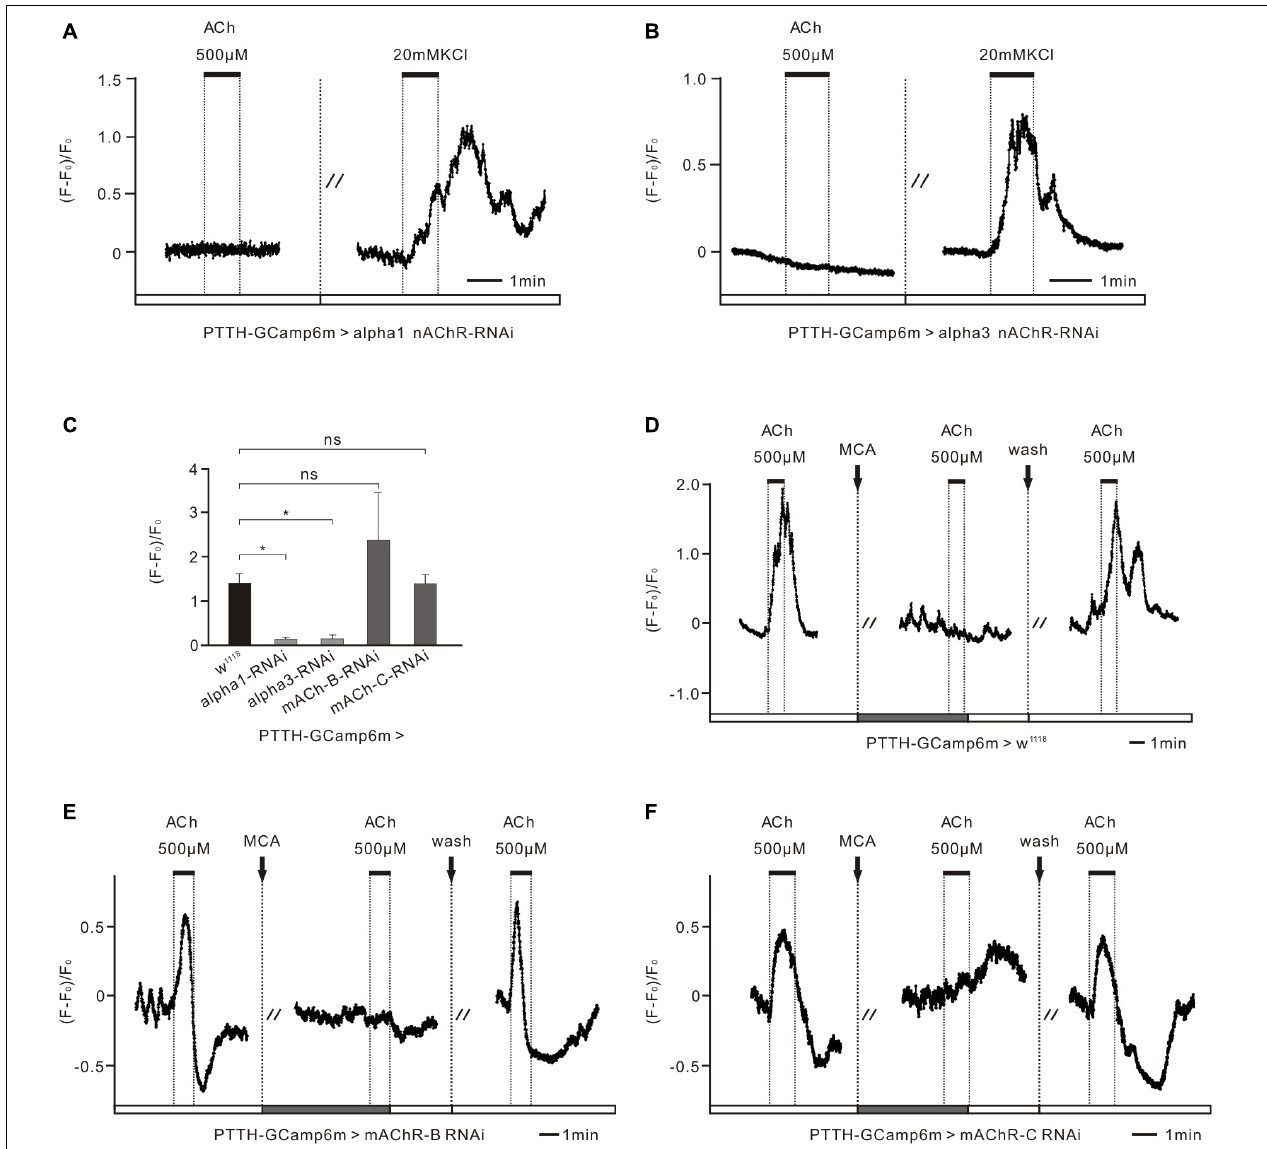
FIGURE 4 | nAChR subunits control the excitatory response of PTTH neurons to ACh in Drosophila larvae. (A,B) Ca 2 + response of two nAChR subunits in the RNAi experimental groups (co-expressing GCaMP6m and nAChR α 1/3 RNAi in PTTH neurons) to 500 µ M ACh and 20 mM KCl ( n = 5). When downregulating the expression of nAChR α 1 and α 3 subunits specifically in PTTH neurons whose activity was demonstrated to be normal by the application of 20 mM KCl, no ACh response was detected. (C) Statistical analysis of the peak amplitude of Ca 2 + response to 500 µ M ACh in all groups ( n = 4–5). The peak amplitude of the response to 500 µ M ACh fell to almost zero after the expression of nAChR α 1/3 was downregulated in PTTH neurons. * p < 0.05; ns, not significant p > 0.05. (D) Ca 2 + response of the w 1118 control group to ACh and the nAChR antagonist mecamylamine (ACh, 500 µ M; MCA, 100 µ M; n = 5). 100 µ M MCA was able to completely block the increased response of PTTH neurons to 500 µ M ACh. (E,F) Ca 2 + response of the other AChR RNAi experimental groups (co-expressing GCaMP6m and mAChR-B/C RNAi in PTTH neurons) to 500 µ M ACh and 100 µ M MCA ( n = 4–5). There were no significant differences between the control group and these experimental groups (C)